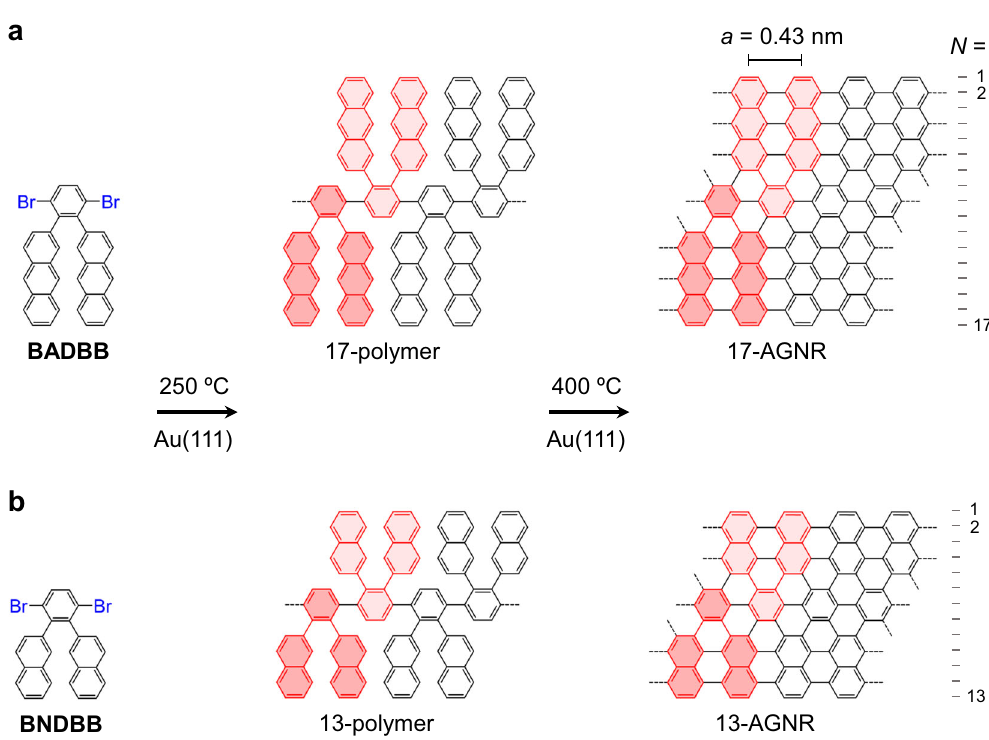
Fig. 1 Bottom-up synthesis of 17- and 13-AGNRs. a , b Schematic drawing of on-surface chemical reactions for a 17- and b 13-AGNRs on Au(111). 17- and 13-polymers are formed via dehalogenation and aryl − aryl coupling of BADBB and BNDBB monomers up to 250 °C, then cyclodehydrogenation of 17- and 13-polymers at 400°C leads to formation of 17- and 13-AGNRs.The relevant lattice parameter of AGNRs is described as a = 0.43 nm in a